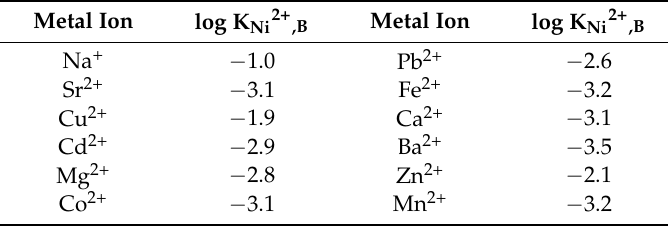
Table 4. Potentiometric selectivity coefficient values for TPA electrode by fixed interference method.